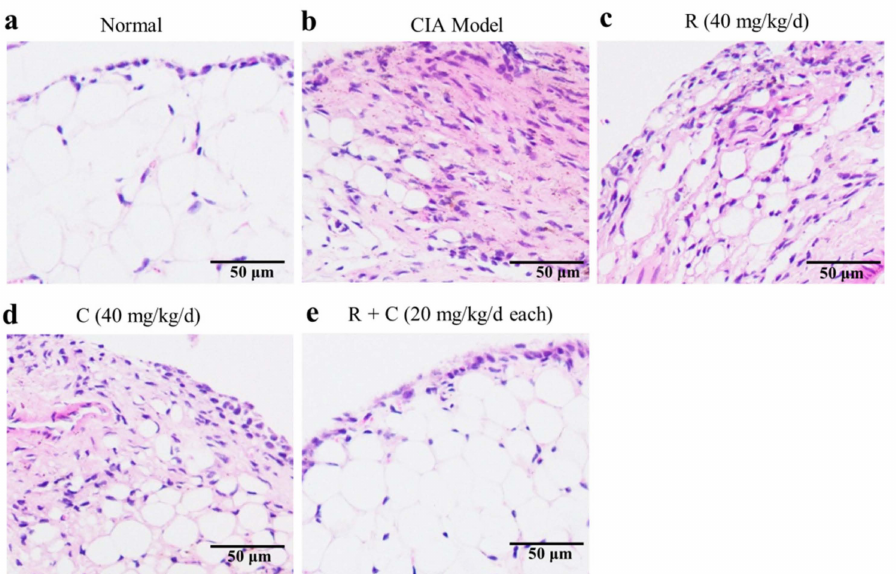
Figure 4. Rosmanol (R), carnosol (C), and their combination (R + C) alleviated synovitis in CIA mice. Representative H&E staining results from synovial tissue samples of the normal group ( a ), model group ( b ), rosmanol-treated group ( c ), carnosol-treated group ( d ), and combination-treated group ( e ) mice are shown (200 × , n = 3).